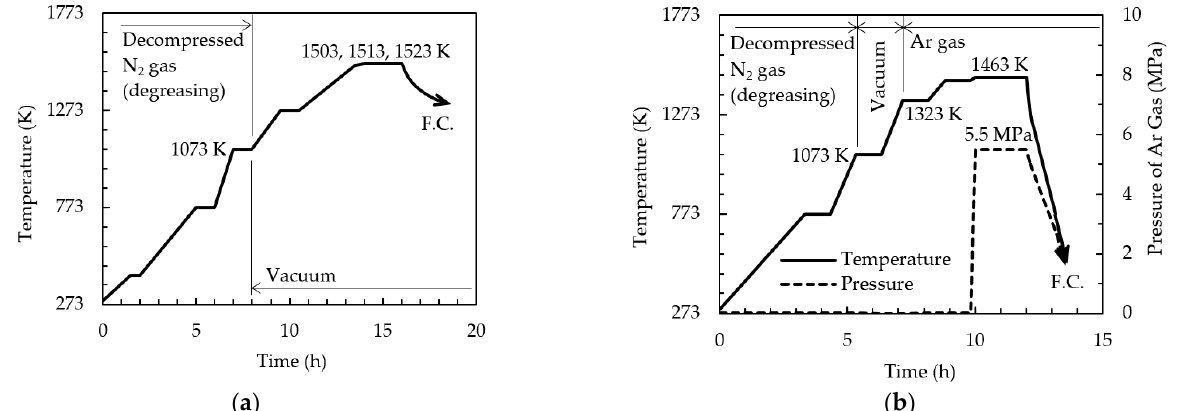
Figure 2. Relationship between time and temperature for sintering ( a ) without S-HIP and ( b ) with S-HIP.